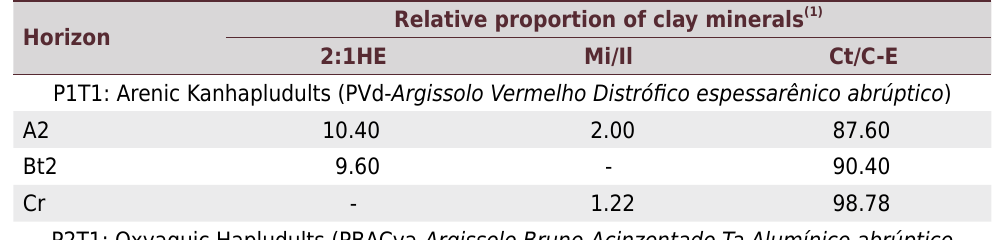
Table 4. Semiquantitative data of clay minerals by XRD technique Relative proportion of clay minerals (1) Horizon